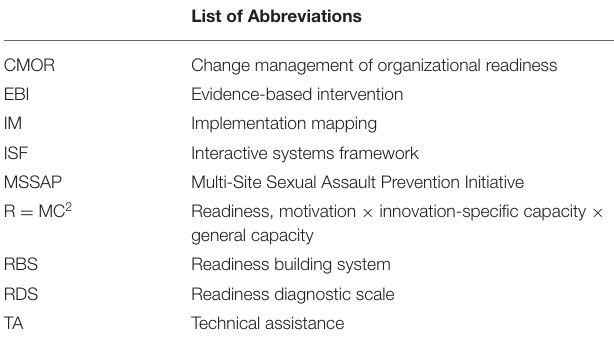
TABLE 1 | List of abbreviations. List of